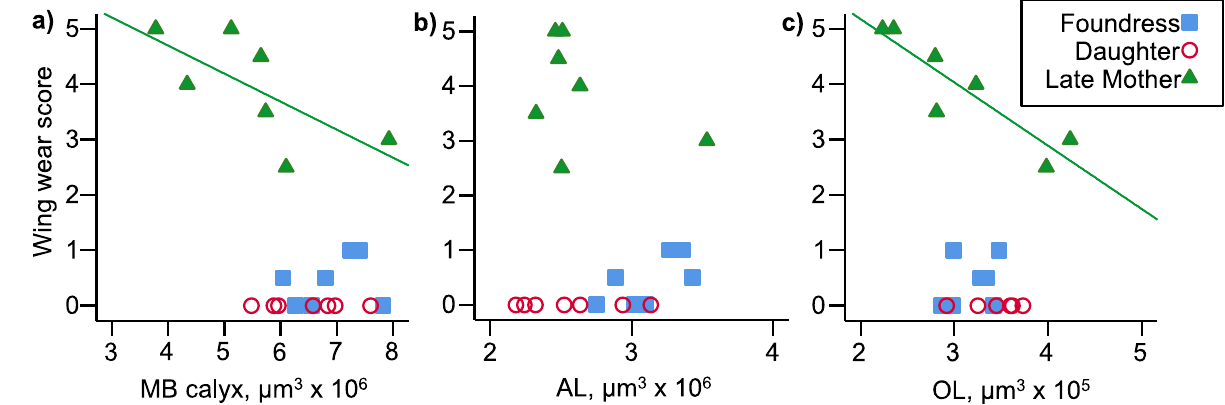
Figure 4. Degree of wing wear plotted against the volume of the MB calyx ( a ), AL ( b ), and OL ( c ). In all panels, late mothers are represented by green filled triangles, foundresses by blue filled squares, and newly emerged daughters by open red circles. Regression lines are shown for statistically significant within-group relationships (Spearman’s rank correlation) only, and represent linear regressions (N = 7 for each group).